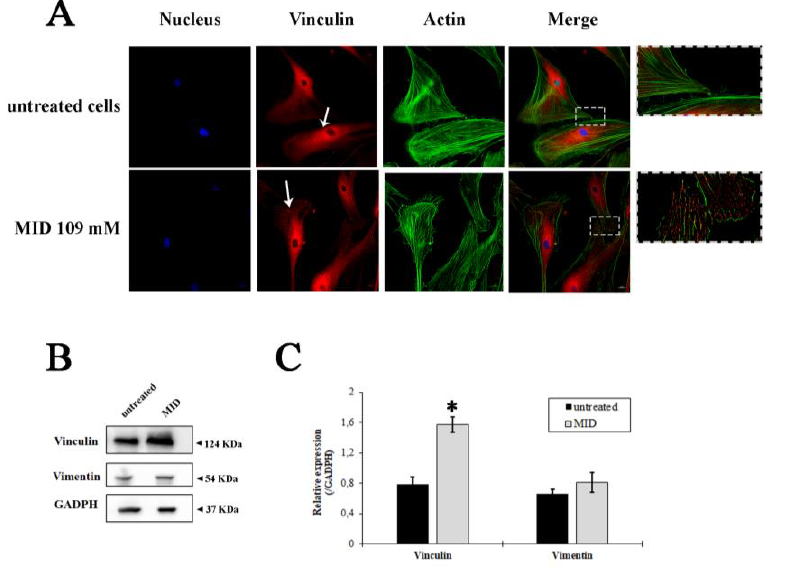
Figure 4. Fluorescence staining of HTMC with FITC-phalloidin (green), Vinculin antibody (red) and Hoechst (blue) after 48 h of treatments with MID. ( A ) Representative fluorescence microscopy images showing cytoskeletal changes characterized by F-actin and vinculin cell distribution. ( B ) Western blotting showing the expression change of vinculin and vimentin in response to MID treatment. The samples derive from the same experiment; gels and blots were processed in parallel and reported in SI. Each blot was cut in order to isolate the individual proteins and probed with specific antibodies, as illustrated in M&M. ( C ) Histogram showing the quantification of the change in vinculin and vimentin expression with respect to GAPDH, used as an internal loading control. * p < 0.05.